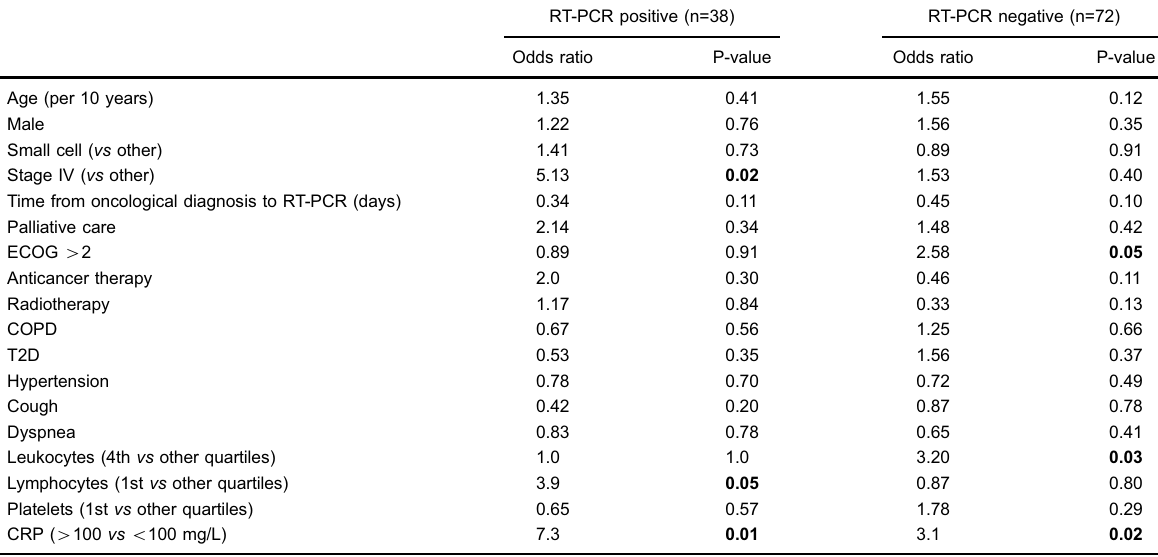
Table 3. Potential predictors of all-cause mortality according to SARS-CoV-2 RT-PCR